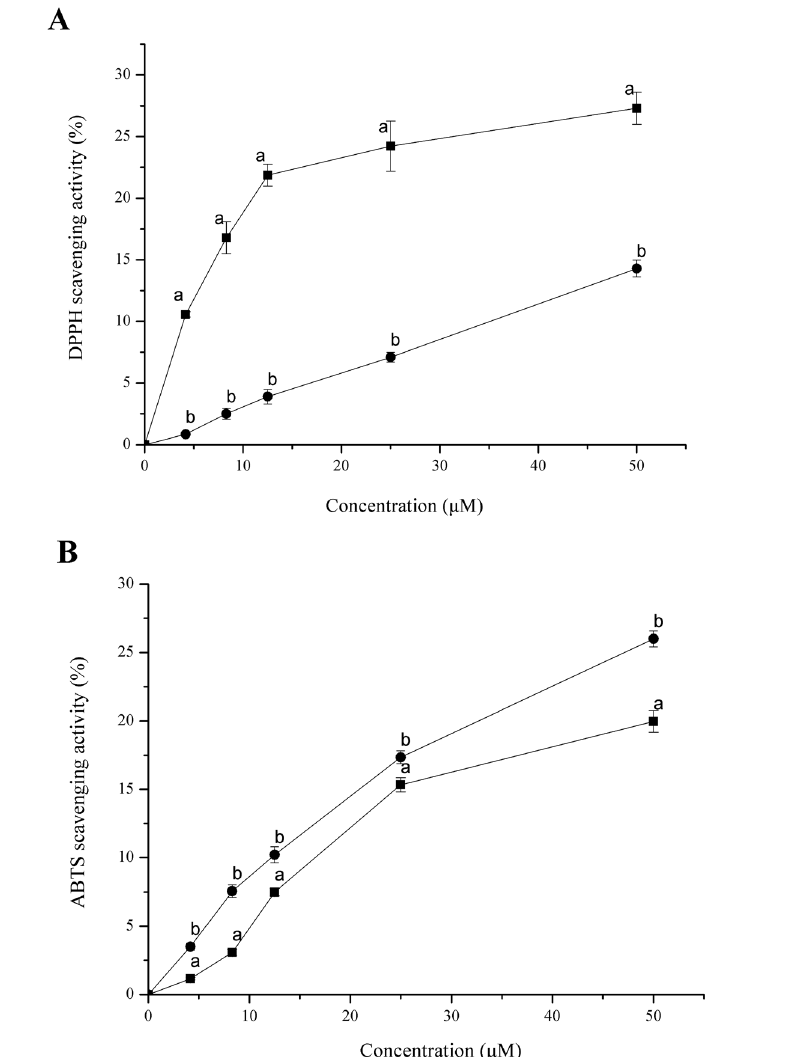
Figure 4. DPPH (A) and ABTS (B) radical scavenging activity of Hsp90 ( ■ ) and glutathione ( ● ). DPPH and ABTS scavenging activity increased with the protein concentration. DPPH, 1,1-diphenyl-2-picrylhydrazyl); ABTS, 2,2’-azinobis(3-ethylbenzthiazoline-6-sulfonic acid; Hsp90, 90 Kda heat shock protein. Bars indicate standard deviation. a,b Different letters indicate significant difference